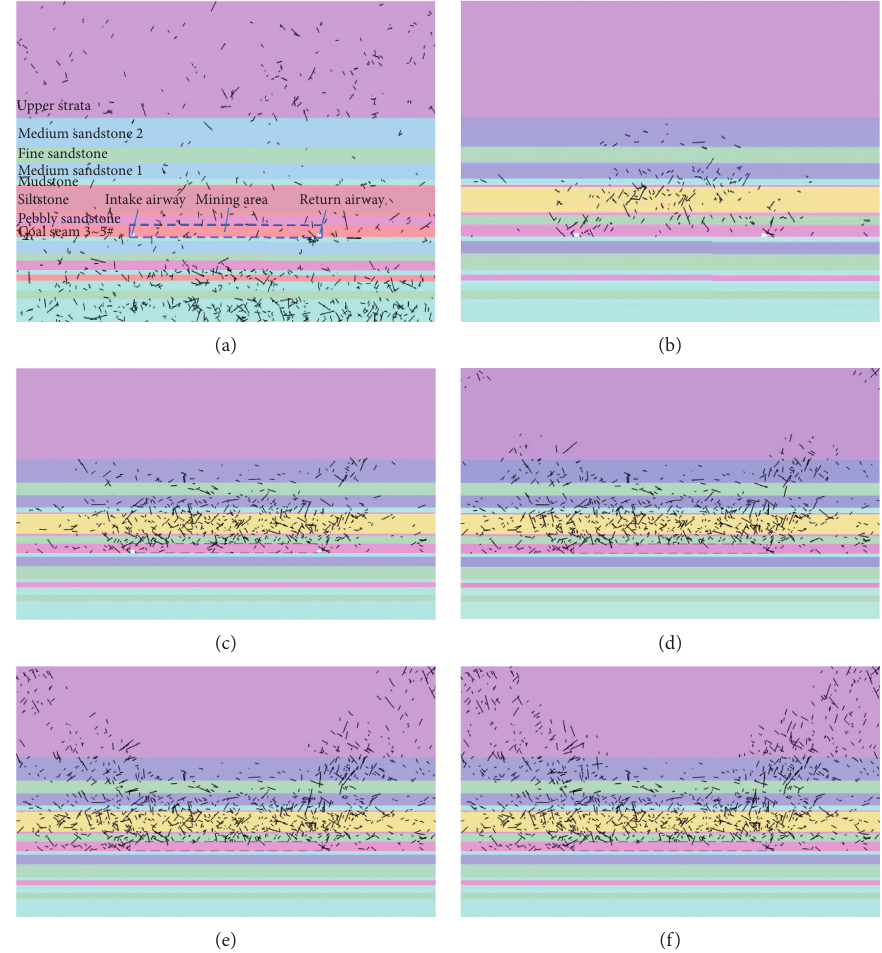
Figure 9: Evolution of the fracture network in section plane 2 as the mining face advances: (a) 100m from the mining face; (b) 50m from the mining face; (c) at the mining face; (d) 50m behind the mining face; (e) 100m behind mining face; (f) 150m behind mining